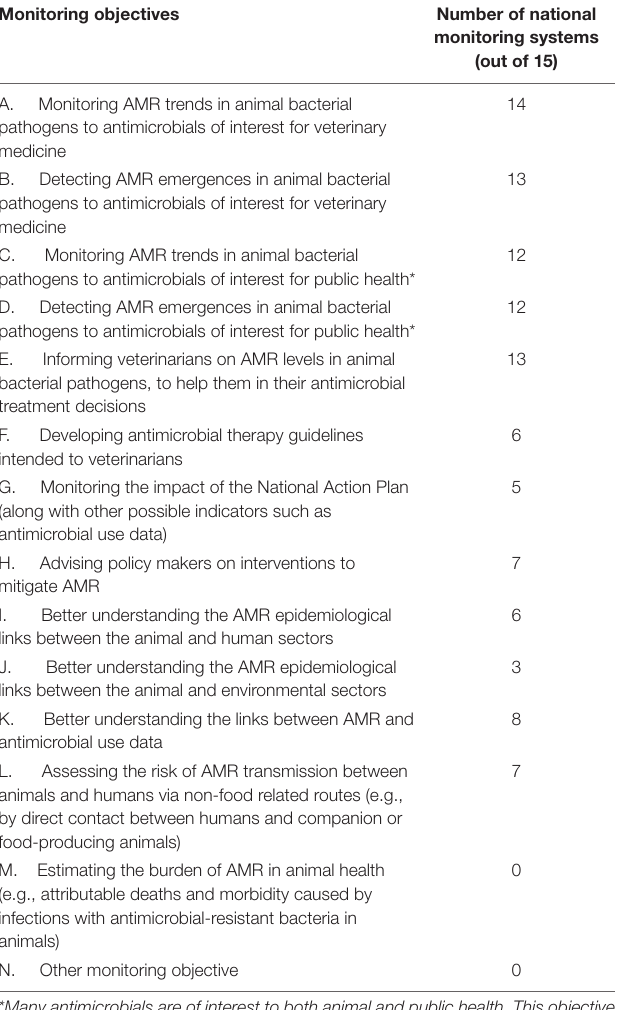
TABLE 2 | Objectives of the 15 reviewed national monitoring systems for antimicrobial resistance in bacterial pathogens of animals. Monitoring